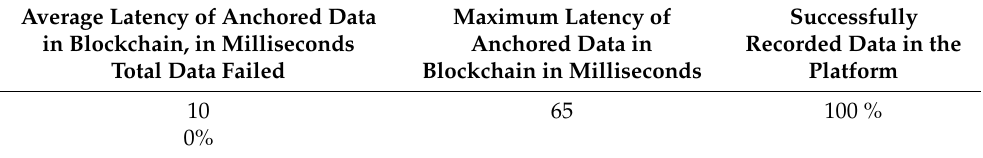
Table 4. Latency data being anchored in Blockchain and percentage of successfully transmitted Data.